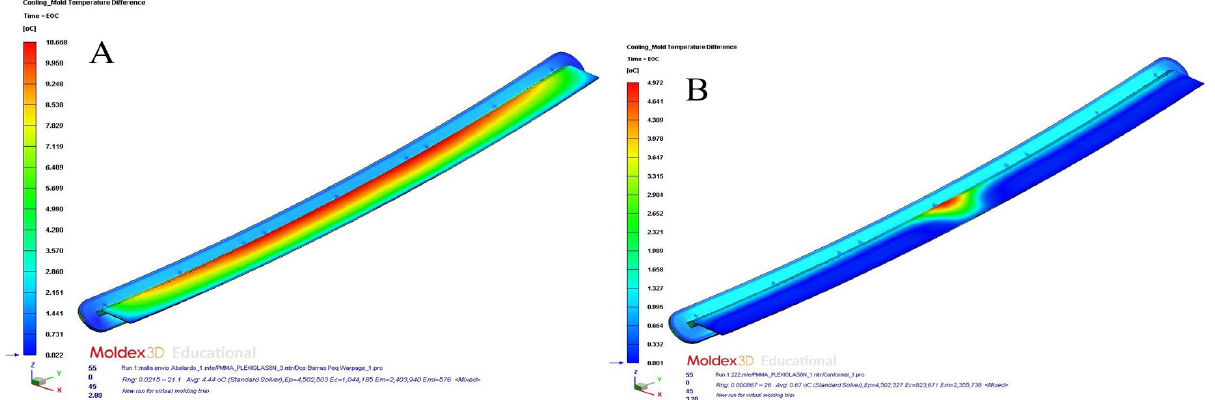
Figure 16. Mold temperature difference (°C); conformal channels—dashed Fastcool bars ( A ), conformal channels ( B ). Table 12. Total warpage parameters for each cooling system designs.